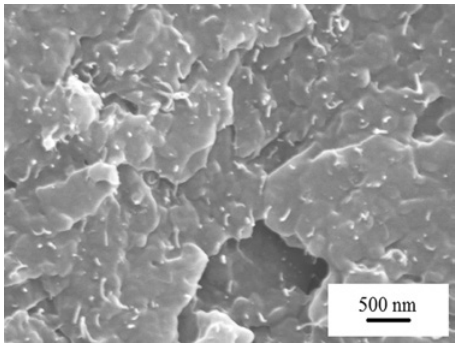
Figure 10: SEM micrograph of the fractured surface of the 2.5 wt.% MWCNT/PC composite obtained at the injection temperature of 330 ° C and injection speed of 10